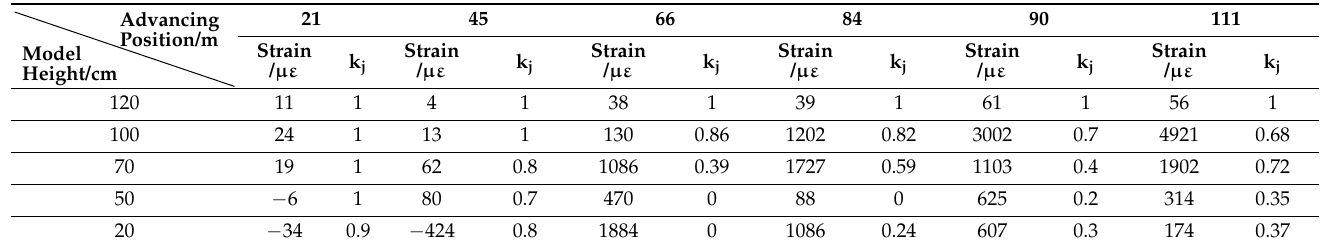
Table 3. Distribution of fiber–rock coupling coefficient in deformation